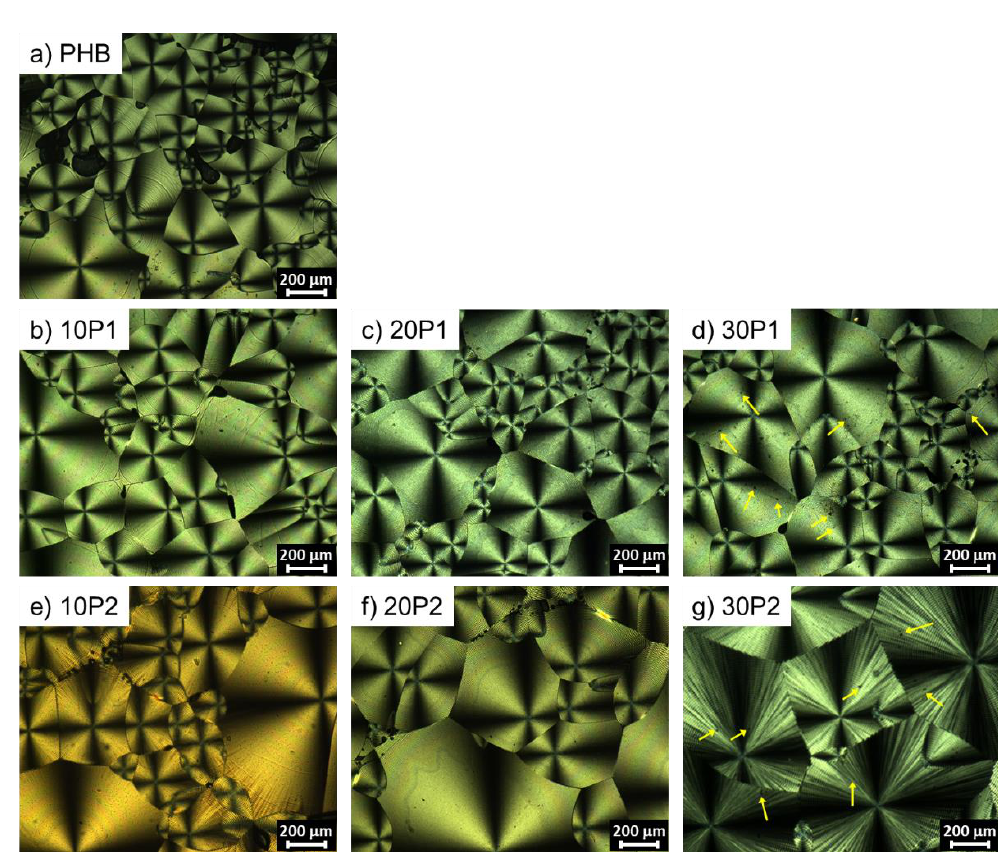
Figure 7. Polarized optical microscopy images of ( a ) PHB, ( b ) PHB/10P1, ( c ) PHB/20P1, ( d ) PHB/30P1, ( e ) PHB/10P2, ( f ) PHB/20P2 and ( g ) PHB/30P2 isothermally crystallized at 60 °C. Yellow arrows indicate dark spots.